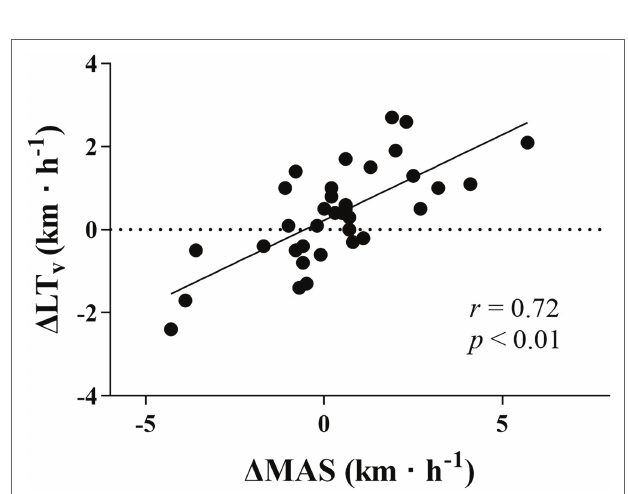
FIGURE 2 | Baseline correlation between velocity at LT (LT v ) measured by blood lactate and LT v predicted by Equation 2. LT v , velocity at lactate threshold; Calc. LT v , calculated LT v by Equation 2; km·h − 1 , kilometers per hour; r , correlation coefficient; and SEE, standard error of the estimate in percentage.